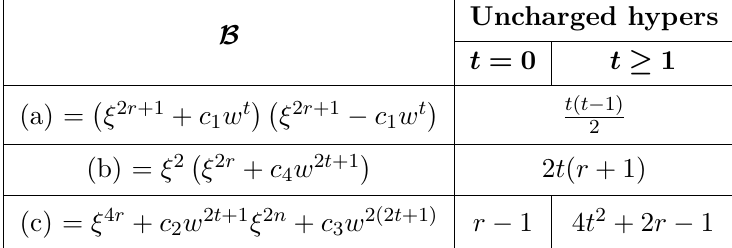
Table 4 . Irreducible blocks and uncharged hypers under discrete symmetries.